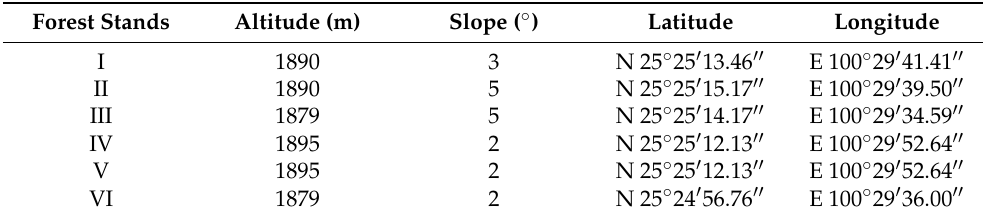
Forest V: Pinus yunnanensis × Celtis tetrandra (2:1); Forest VI: Pinus yunnanensis pure